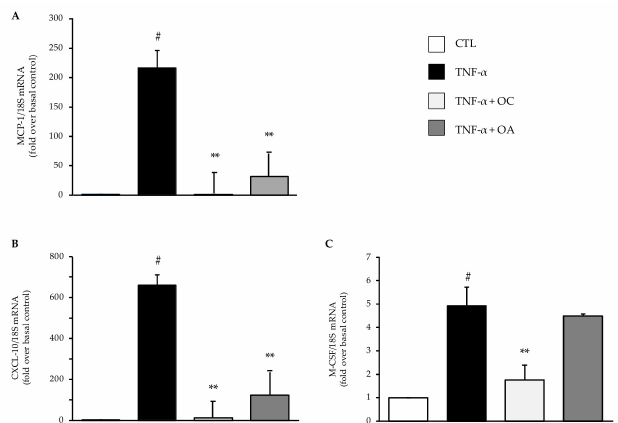
Figure 3. Modulation by OC and OA of mRNA expression levels of chemokines associated with adipocyte inflammation. SGBS adipocytes were pretreated with OC or OA 25 µ mol / L (6 h) and then treated with 10 ng / mL TNF- α for 18 h. Total RNA was extracted from cells, and mRNA levels of the monocyte chemoattractant protein (MCP-1) ( A ), C-X-C Motif Ligand 10 (CXCL-10) ( B ), and macrophage colony-stimulating factor (M-CSF) ( C ) were measured by qPCR using specific primers and probes and normalized to 18S RNA. Data (means ± SD, n = 3) are expressed as fold induction over unstimulated control (CTL). # p < 0.05 versus CTL. ** p < 0.01 versus TNF- α alone.